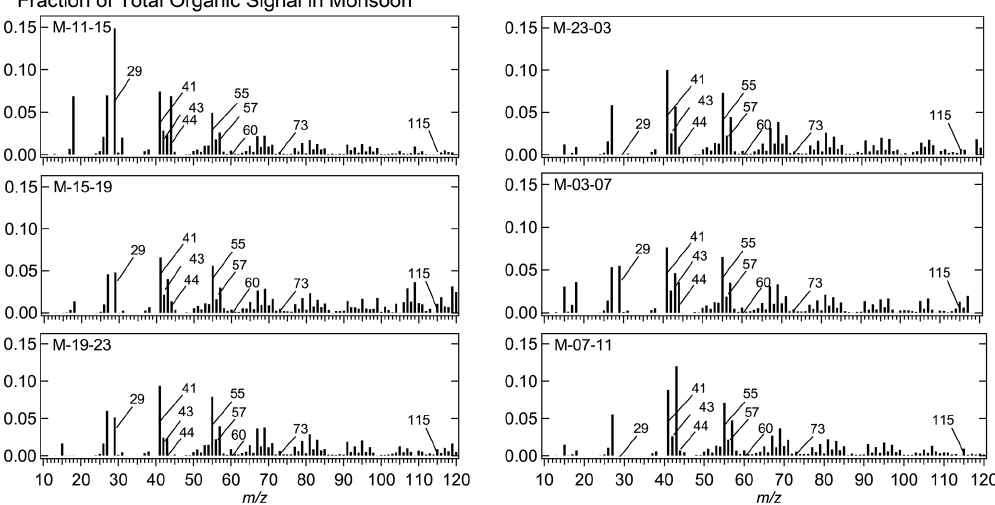
Figure 9. The mass spectrum of the time-of-day PMF cooking organic aerosol (COA) factor in the 2017 monsoon season. The mass spectra show important differences across the time-of-day